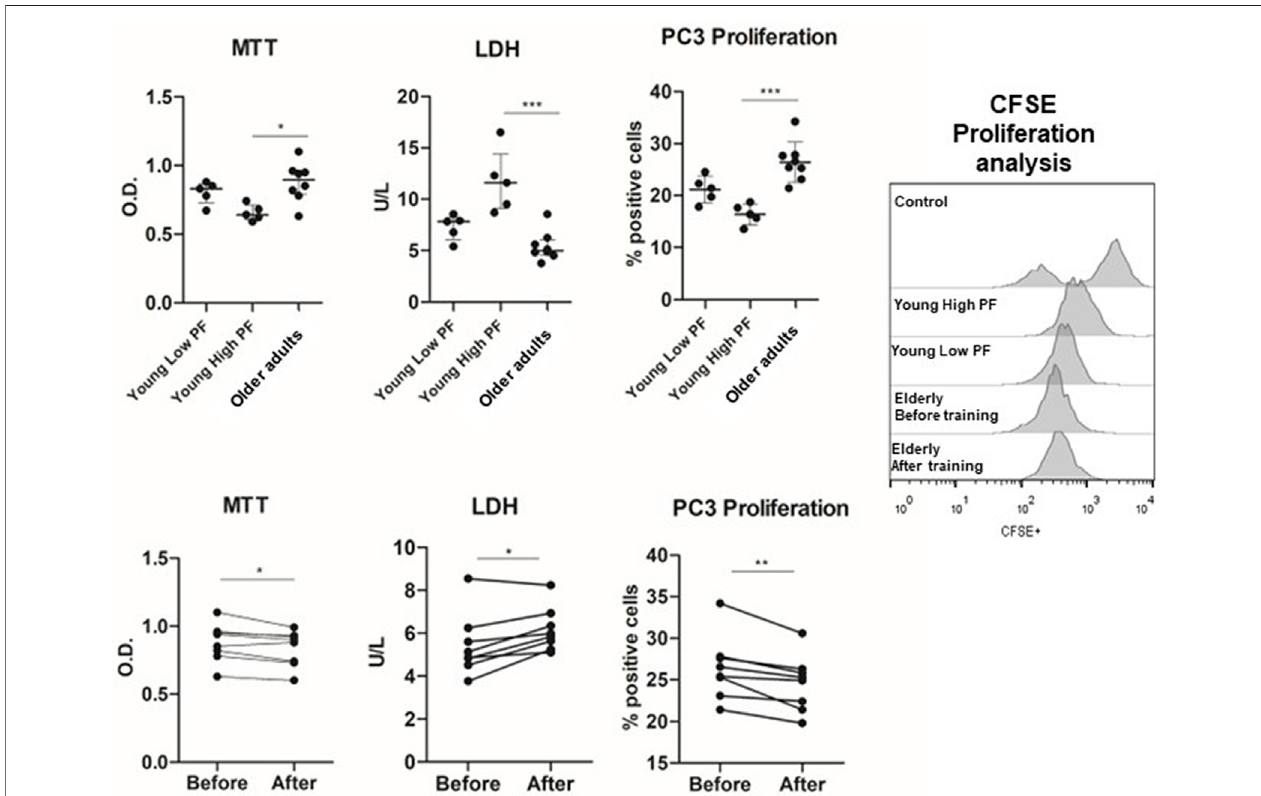
FIGURE 1 | Effects of plasma from young high-PF adults ( n = 5), young low-PF adults ( n = 5), and older adults ( n = 8) submitted to multimodal exercise training on viability and proliferation of the PC3 prostate cancer cell line. PC3 prostate cancer cell lines were incubated with the plasma of young high-PF adults and young low-PF adults and with the plasma of institutionalized older adults obtained before training and 48 h after 8 weeks of exercise training. Cell viability was evaluated by MTT and LDH activity and proliferation by the drop of CFSE fl uorescence in PC-3 cells after 48 h of cell culture. All experiments were done in triplicate, and the results are shown as the mean of triplicates from three independent experiments. * p < 0.05; ** p < 0.01; *** p < 0.001.